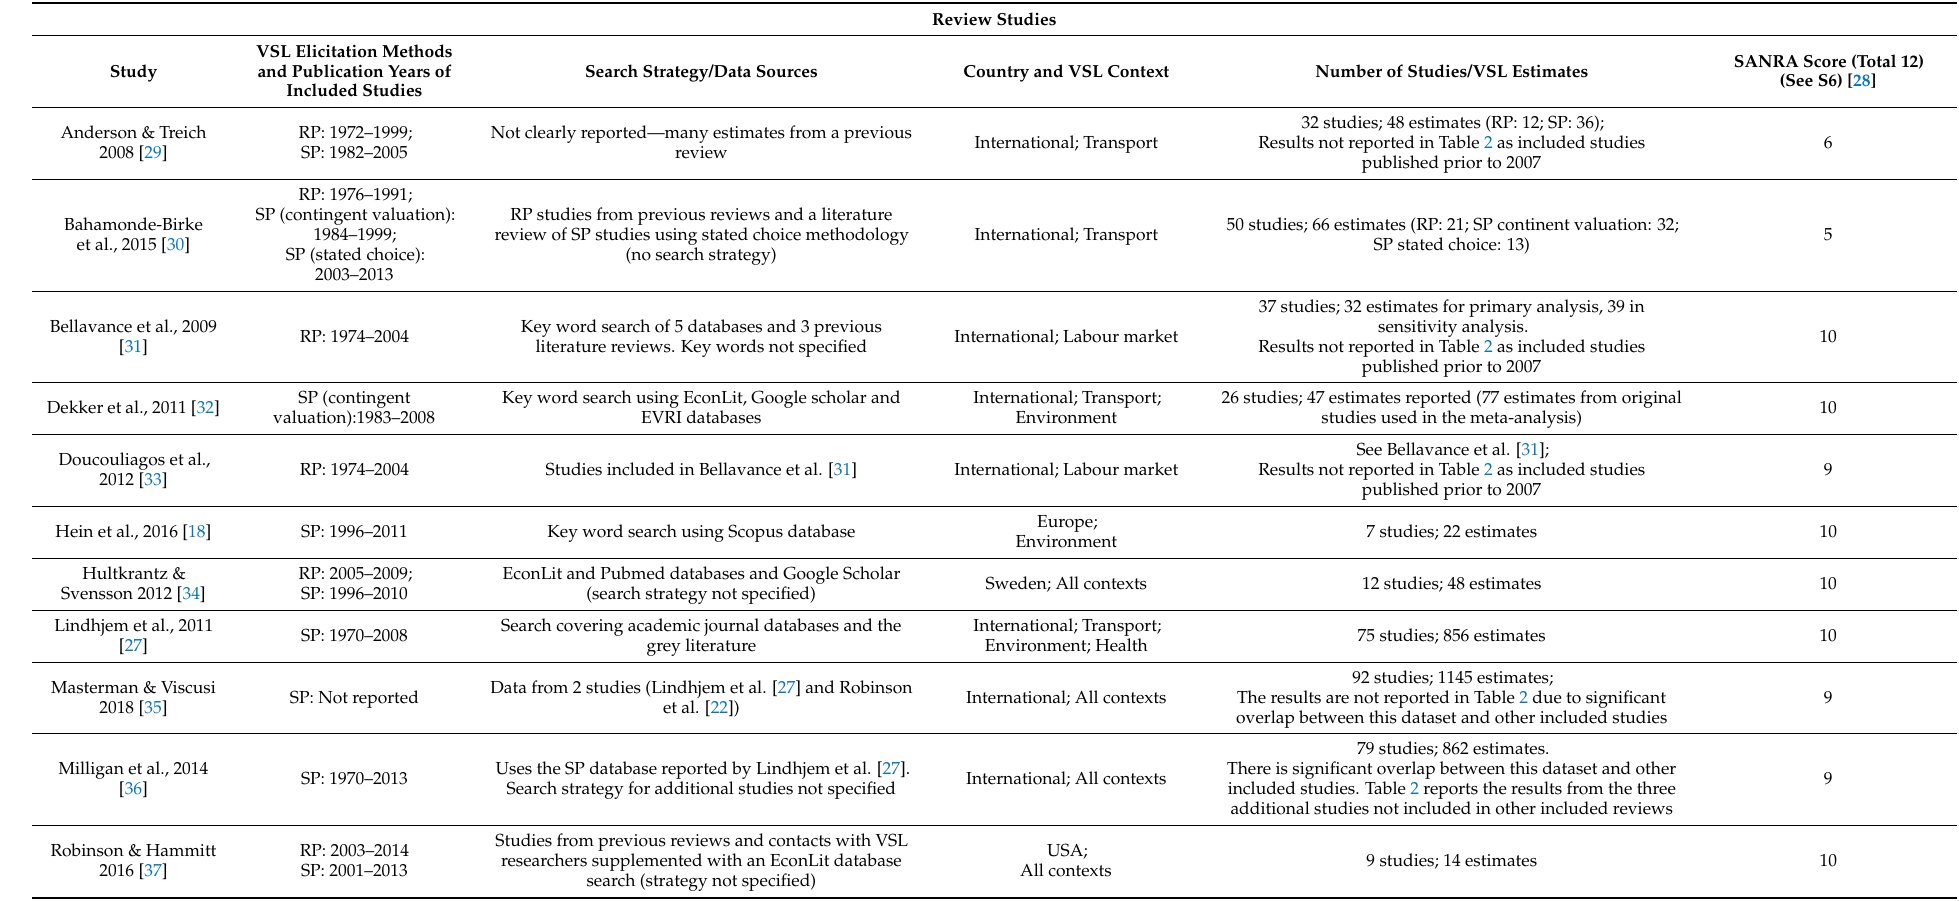
Table 1. Details of included